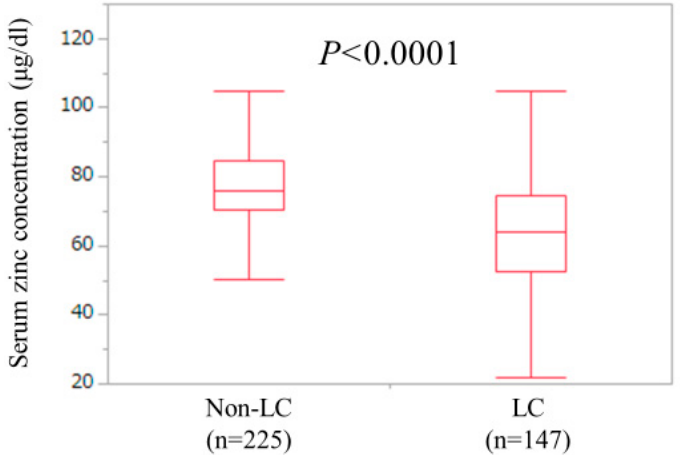
Figure 3. Serum Zn concentrations in LC ( n = 147) and non-LC ( n = 225) patients. The median (IQR) serum Zn concentration for LC cases (63.8 (52.7, 74.4) µ g/dL) was significantly lower than that for non-LC cases (75.8 (70.45, 84.45) µ g/dL) ( P < 0.0001).